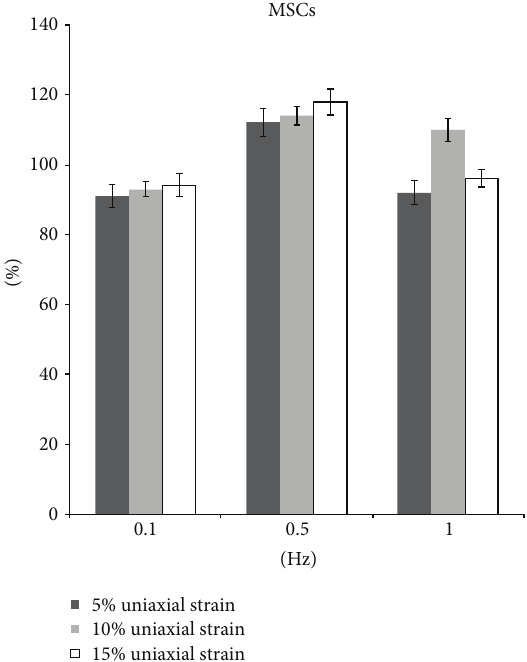
Figure 4: The collagen production of fibroblasts after uniaxial stretch stimulation.